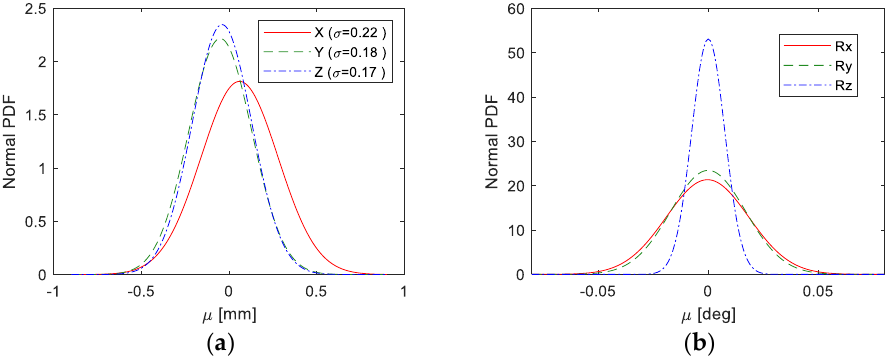
Figure 5. Flowchart of the orientation noise modelling approach.